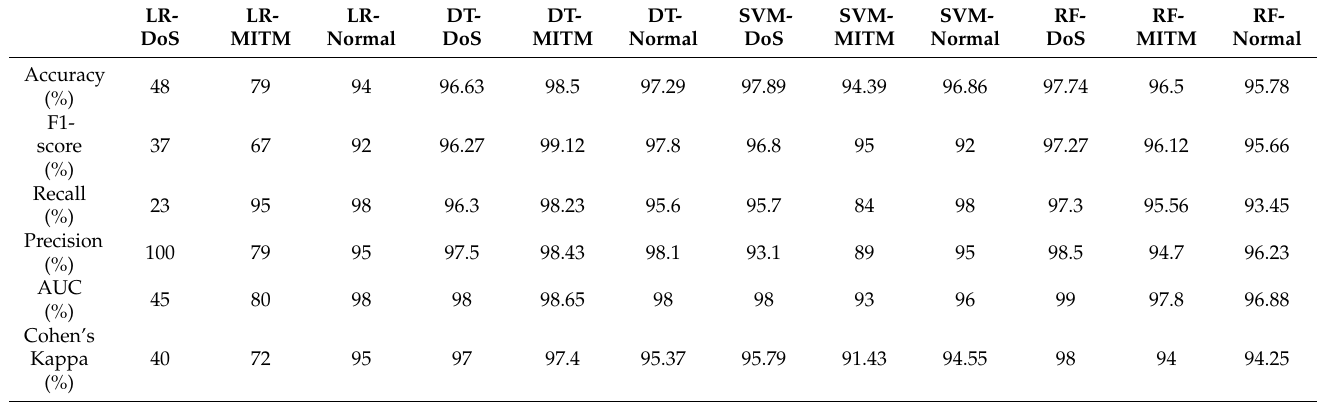
Table 9. Performance analysis of the multiclass classification of the BLE IDS using supervised– ML